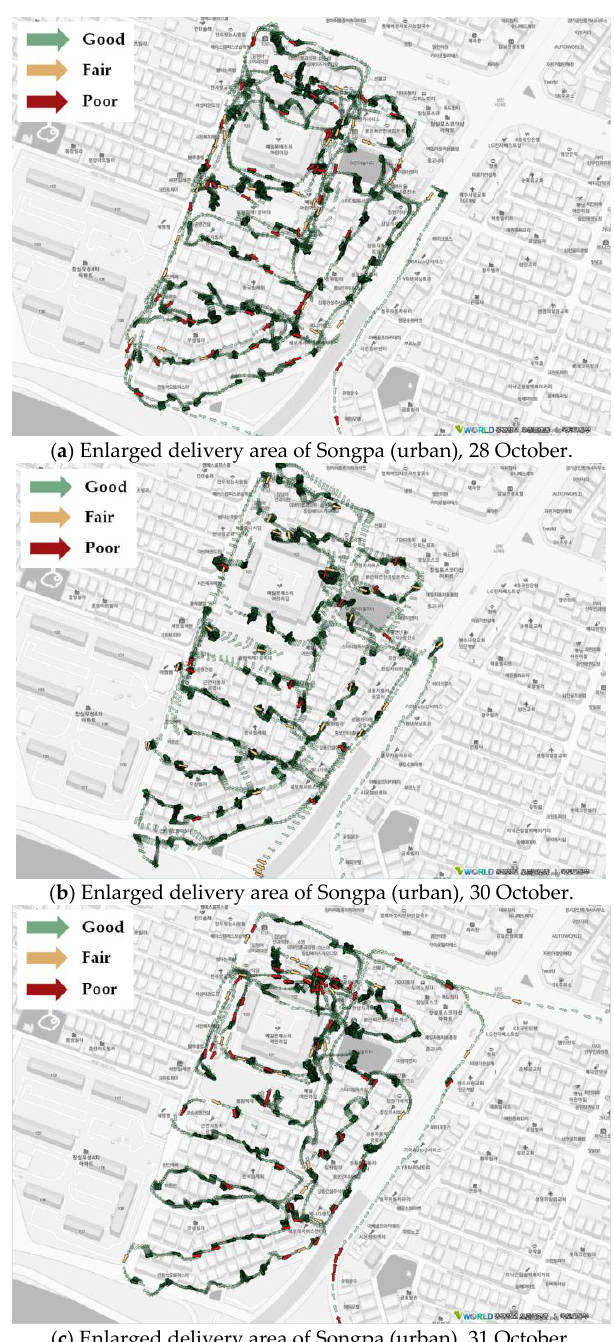
Figure 3. Distribution of a postal motorcyclist’s safety index plotted on a delivery route in Songpa over three days. Enlarged